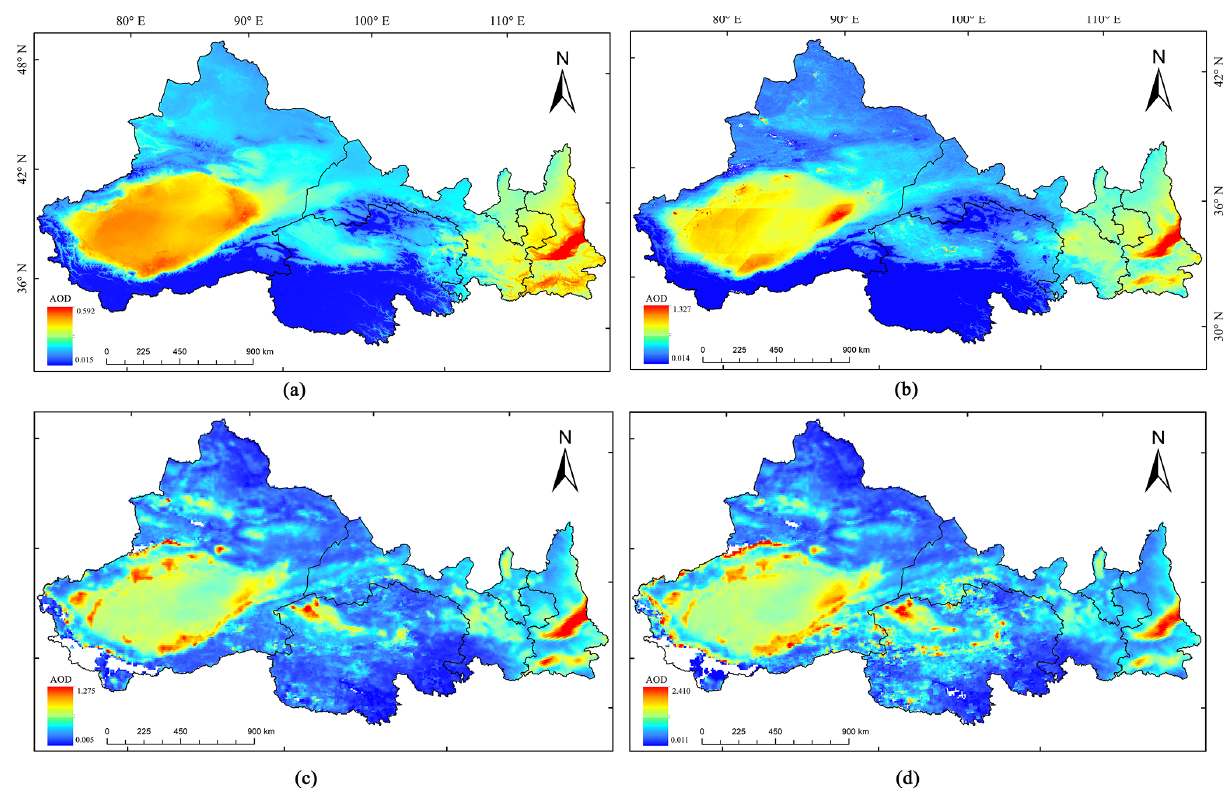
Figure 4. The multiyear spatial average AODs from 2000 to 2019: (a) FEC AODs, (b) MAIAC AODs, (c) MOD04L2 AODs, and (d) MYD04L2 AODs.